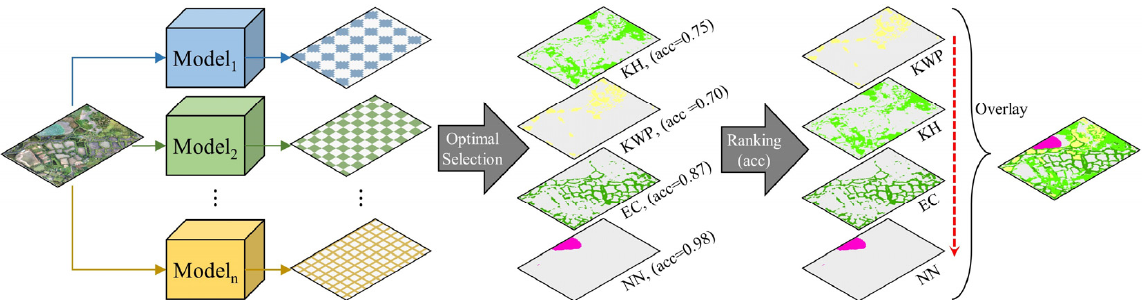
Figure 10. The framework of optimal selection fusion method.